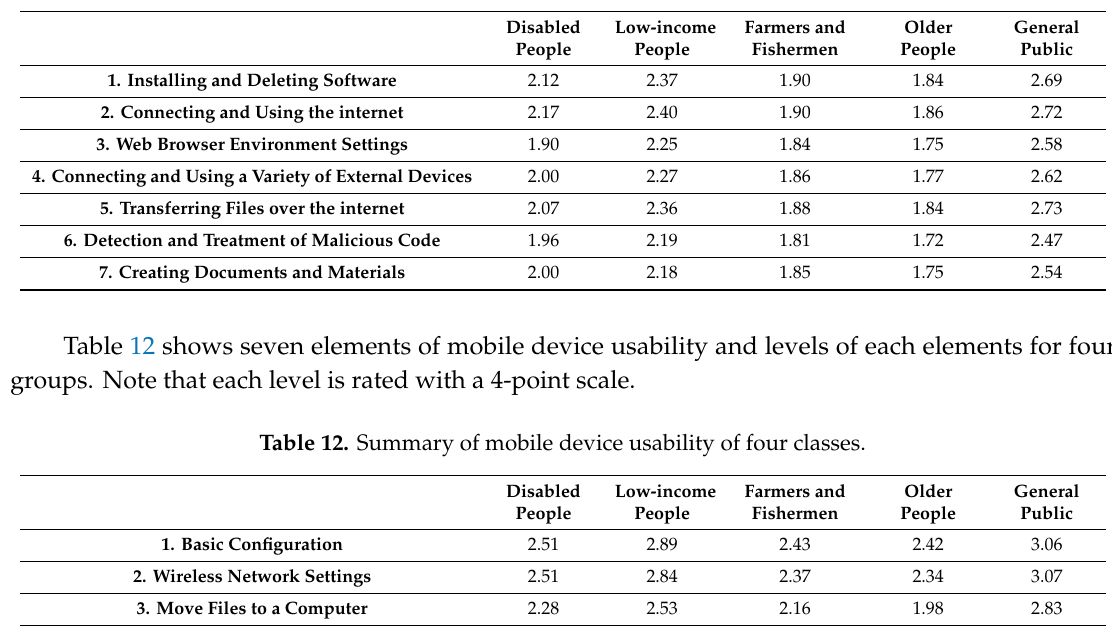
Table 11. Summary of PC usability of four classes.